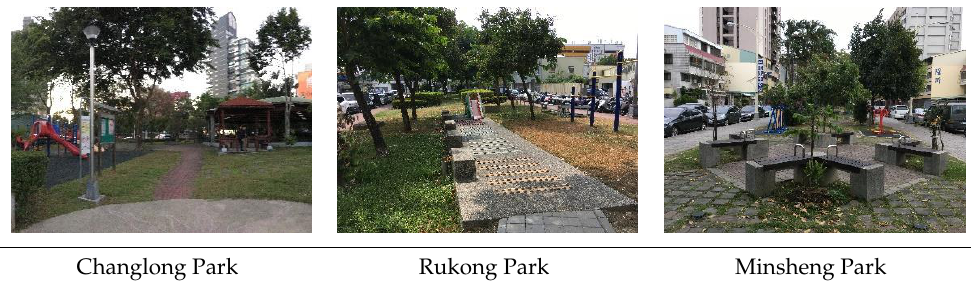
Table 2. Photos of research sites.